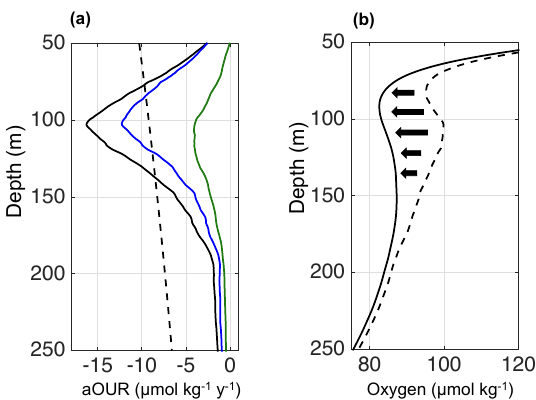
Figure 9. (a) Depth profile of the apparent oxygen utilization rate (aOUR, µmolkg − 1 yr − 1 ) for the Atlantic as published from Karstensen et al. (2008; dashed black line). The oxygen consump- tion profile due to low-oxygen eddies referenced for the SOMZ region (solid black line) and the separation into CEs (blue) and ACMEs (green). The solid black line in (b) represents the observed mean vertical oxygen profile of all profiles within the SOMZ against depth, whereas the dashed black line represents the theoretical ver- tical oxygen profile in the SOMZ without the dispersion of low- oxygen eddies. Naturally due to the dispersion of negative oxygen anomalies, the observed values (black line) are lower than the theo- retical oxygen concentrations in the SOMZ without eddies (dashed black line). The impact of the dispersion of low-oxygen eddies on the oxygen budget in the depth of the shallow oxygen minimum zone is also indicated by the thick black